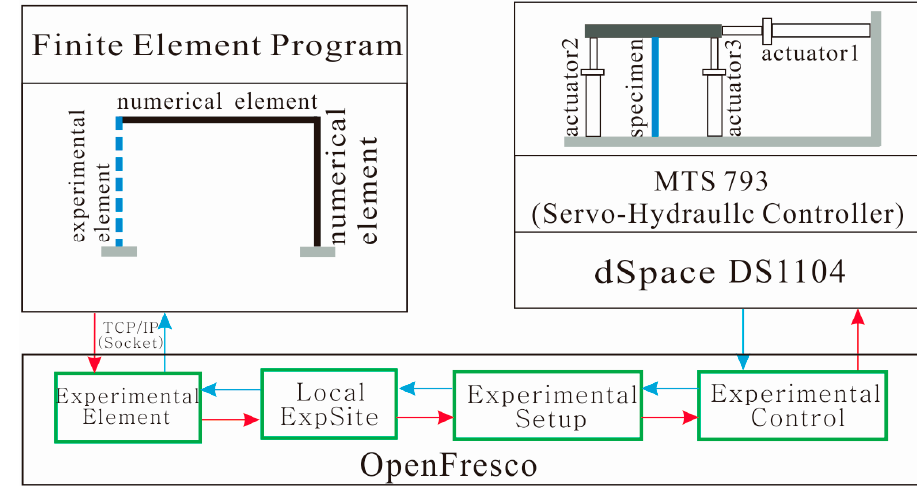
Figure 2. Block diagram of data communication and hardware for hybrid simulation.